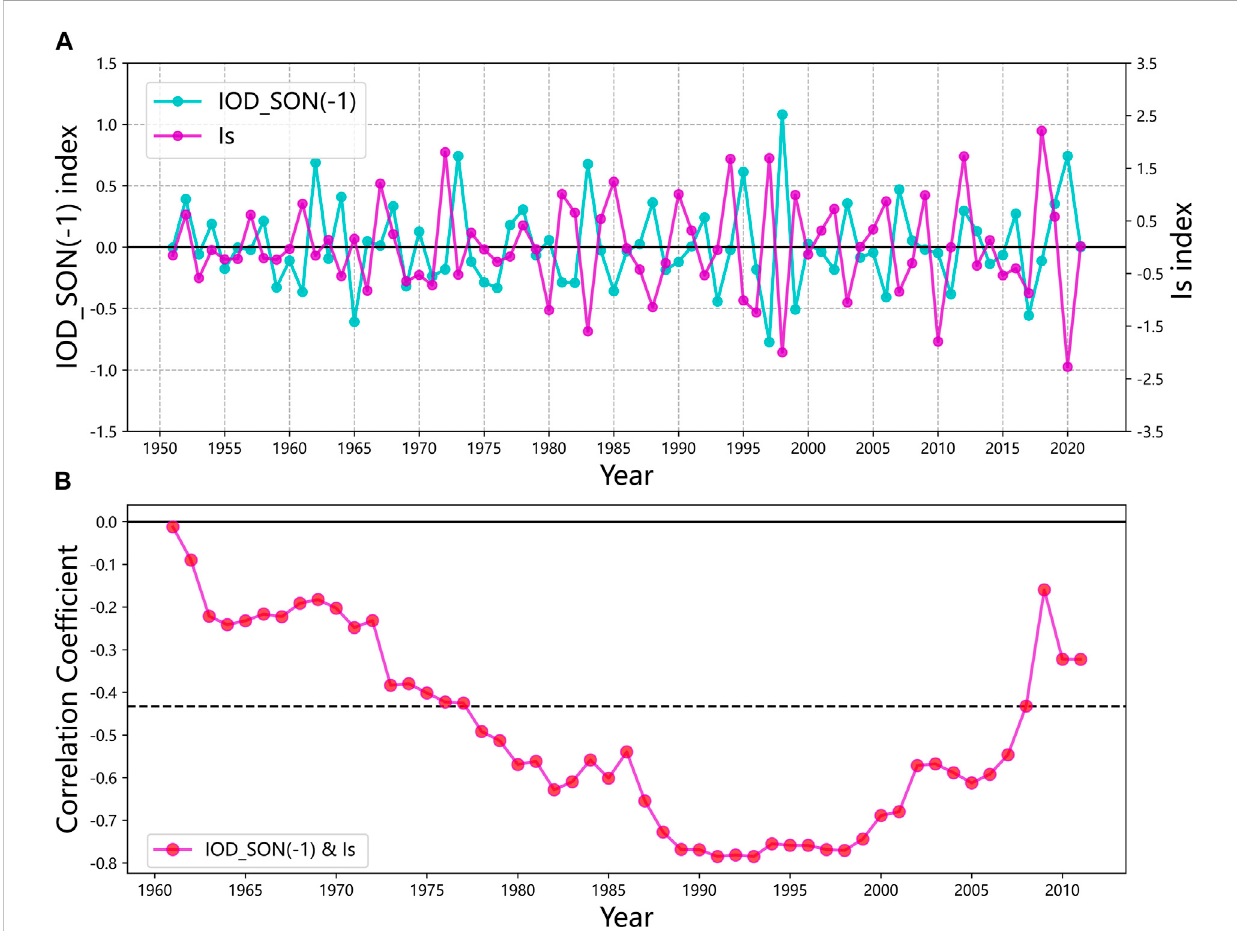
FIGURE 1 (A) Time series of Is and the previous autumn IOD index from 1951 to 2021. (B) The 21a sliding correlation coef fi cient of the SCSSM index with the previous autumn IOD index (the year in the fi gure represents the center of the sliding window. The dashed black line indicates the statistical signi fi cance level of 0.05